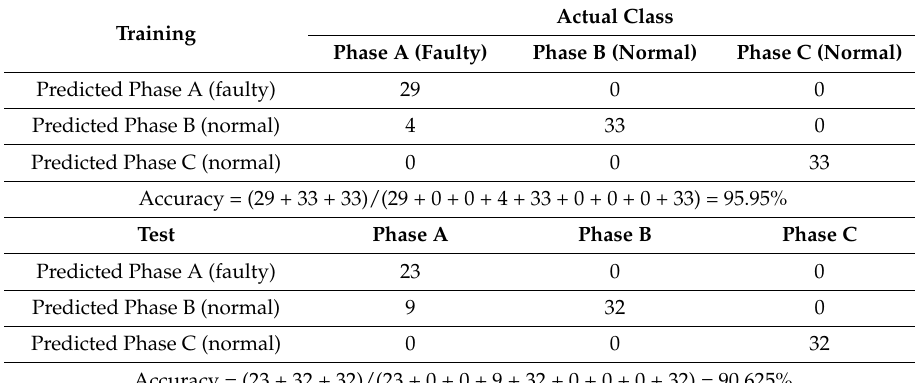
Table 9. Confusion matrix for faulty phase detection using SK and SVM in case study 2.